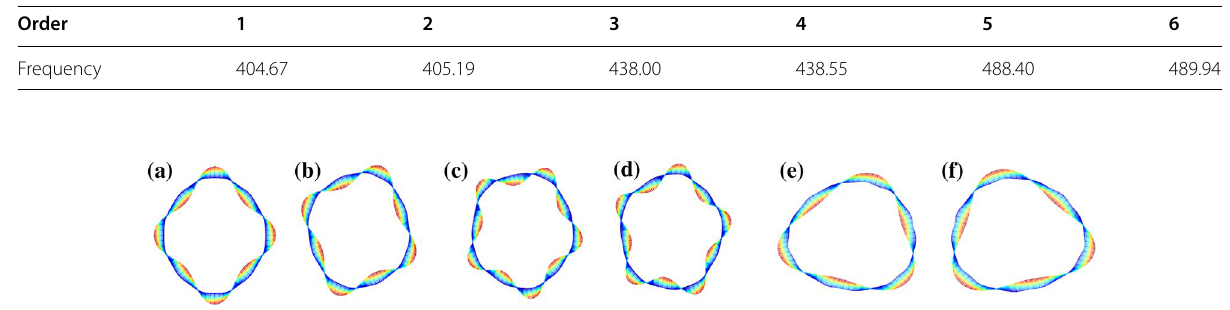
20%: a The first order; b the second =